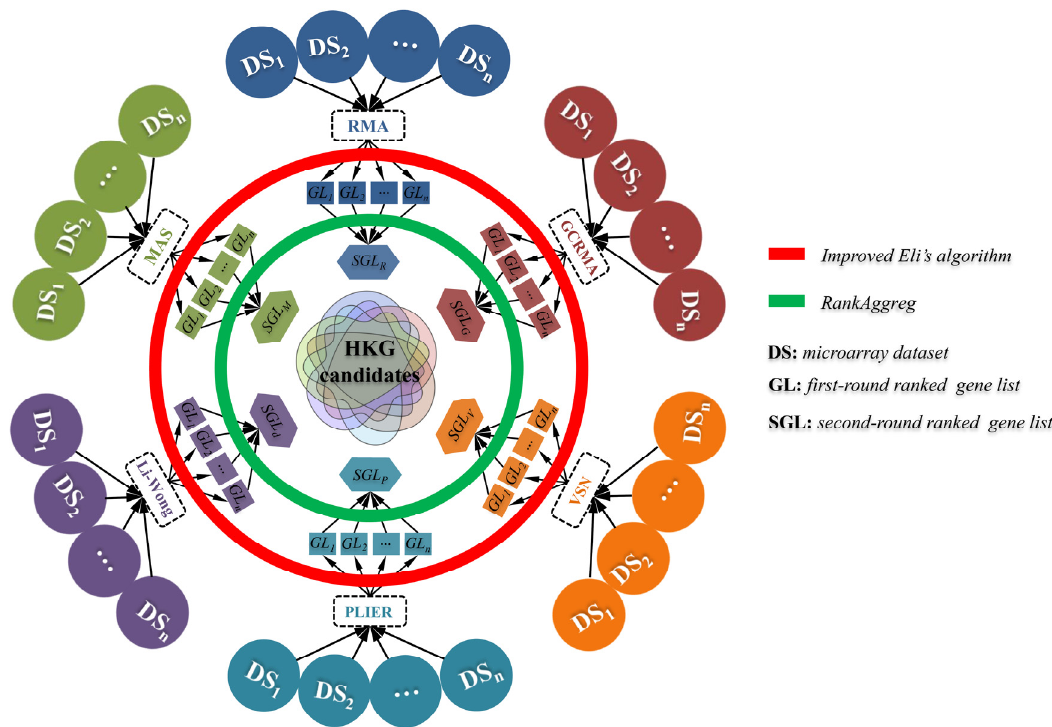
Figure 1. The workflow for the identification of housekeeping gene (HKG) candidates. Briefly, gene expression matrix (GEM) for each microarray dataset was obtained by normalizing raw data using six algorithms ( RMA , MAS5 , Li-Wong , GCRMA , PLIER , and VSN , respectively), and the corresponding first-round ranked gene lists (abbr. GL, from GL 1 to GL n ) were achieved based on gene expression stability. And then, multiple GLs derived from the algorithm-specific normalization were merged as the second-round ranked gene list (abbr. SGL) using RankAggreg algorithm and produced six SGLs (SGL R , SGL M , SGL d , SGL G , SGL P , and SGL V ). Finally, these six SGLs were intersected to obtain the final reliable HKG candidates.